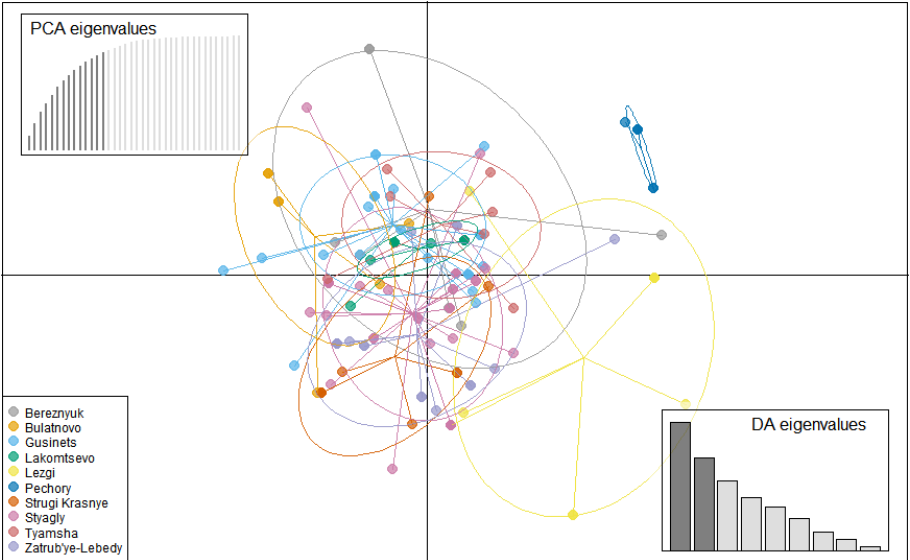
Figure 4. A discriminant analysis of the principal components (PC) scatterplot showing clustering of P. infestans isolates according to locations (non-clone corrected). Clusters representing each location are indicated by the color-coded ellipses. Scatterplots represent the distribution of individuals along the first two linear discriminants. Dots represent isolates’ multilocus genotypes (in each population). The cross-validated number of the PCs used for the discriminant analysis is shown in the bar plots on the top left of the scatterplot. Indicated at the bottom right corner is the discriminant analysis eigenvalues, respectively. A total of 14 PCs explained 99.4% of the variation.